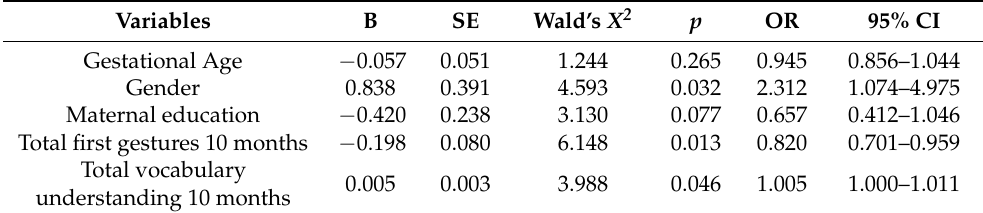
Table 6. Logistic regression analysis: predictors of language delay (LD) in word production at 22 months (IDHC).